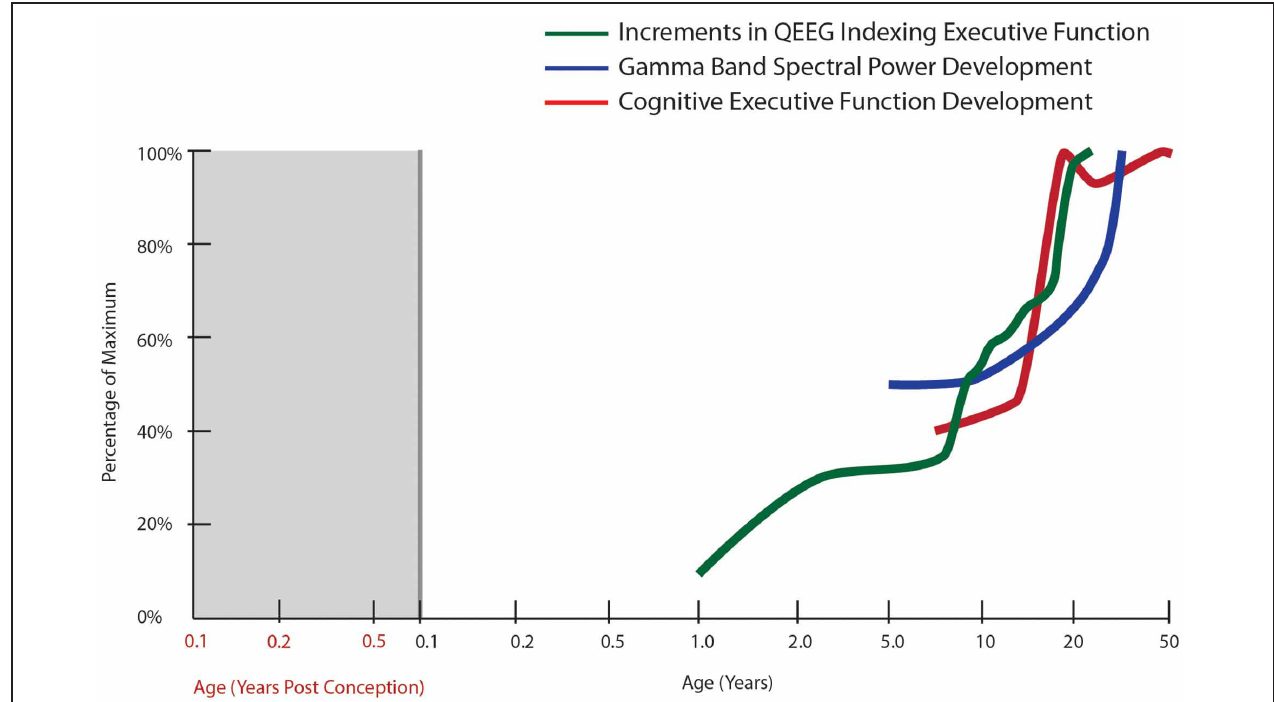
spectral power in gamma bands during a face recognition task (30–75Hz, all electrodes; Uhlhaas et al., 2009) as well as cumulative increments in computer quantified changes in EEG frequency spectrum (QEEG) between fronto-temporal cortices, derived from Hudspeth and Pribram